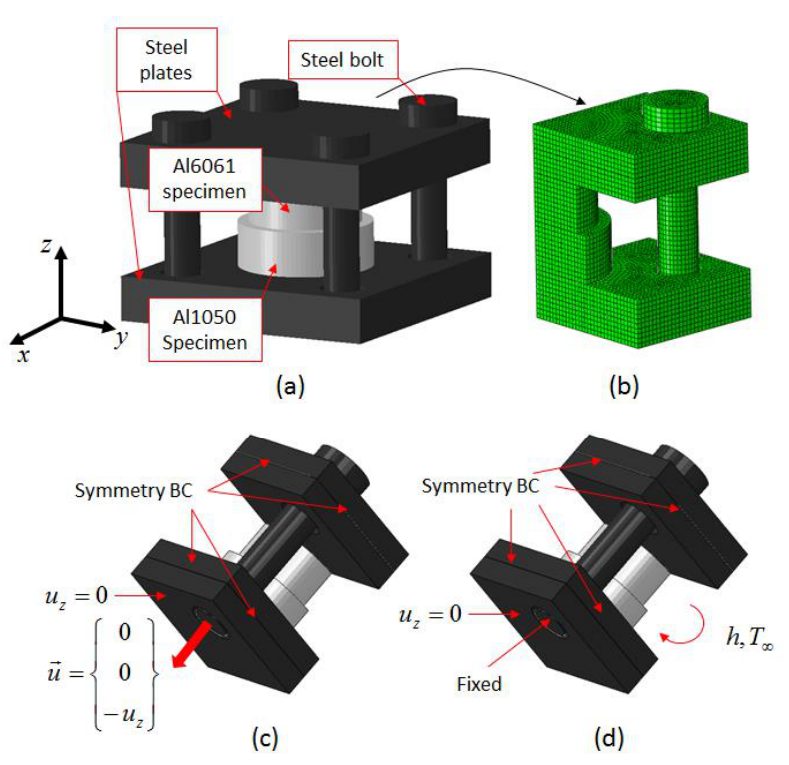
Figure 7. Finite element model of the bonding system: ( a ) Model geometry (mirrored to show the whole system), ( b ) Representative mesh, ( c ) bolt tightening stage, ( d ) heating stage.